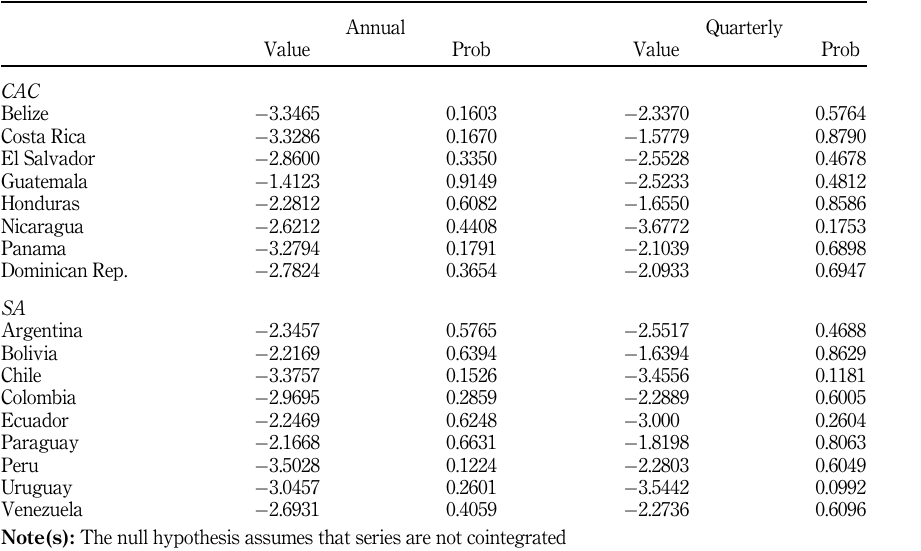
Table A4. Cointegration